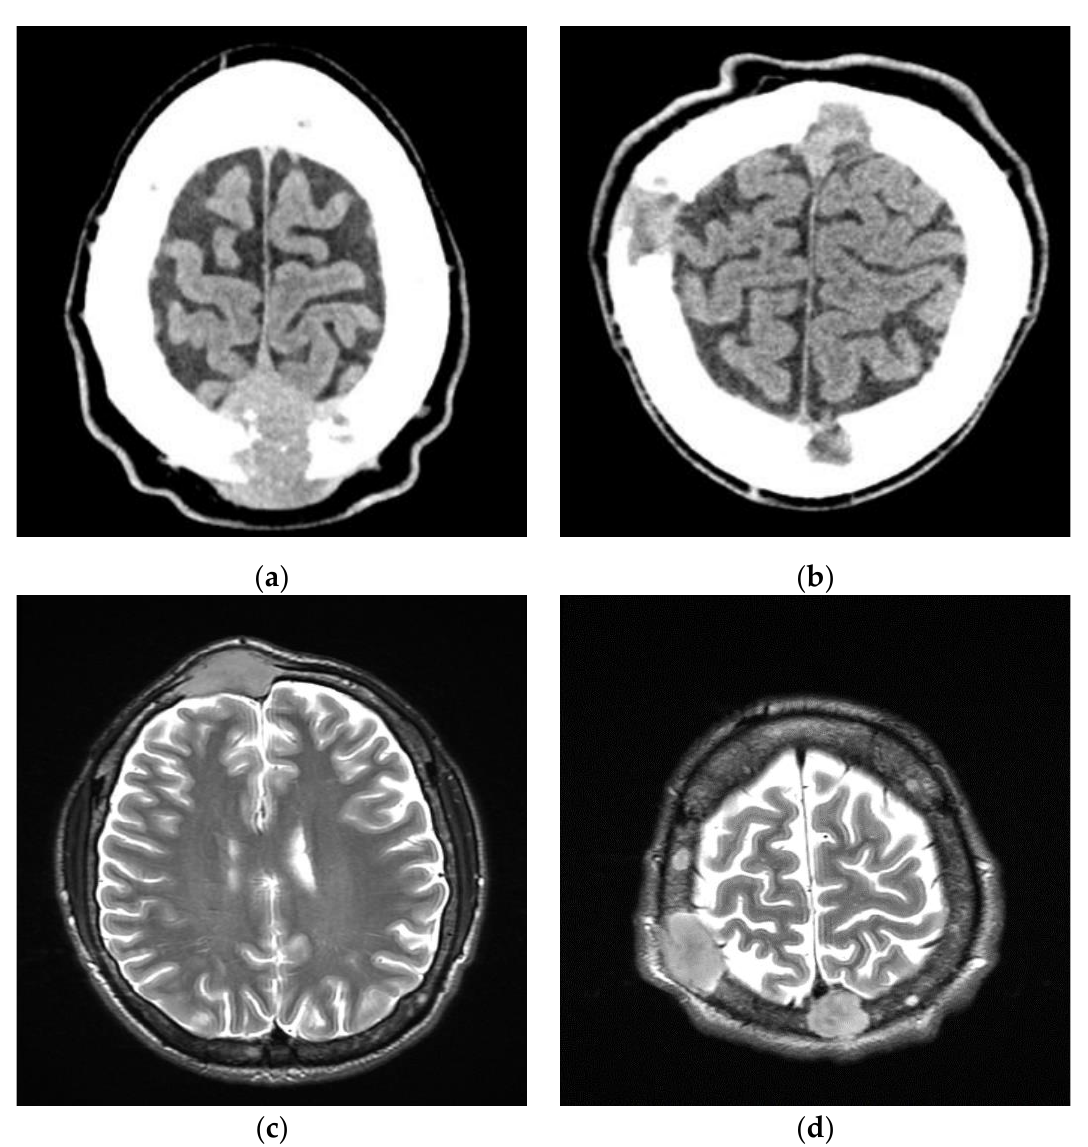
Figure 1. CT ( a , b ) and MRI ( c , d ) scans of plasma cell tumor infiltrating central nervous system (CNS).